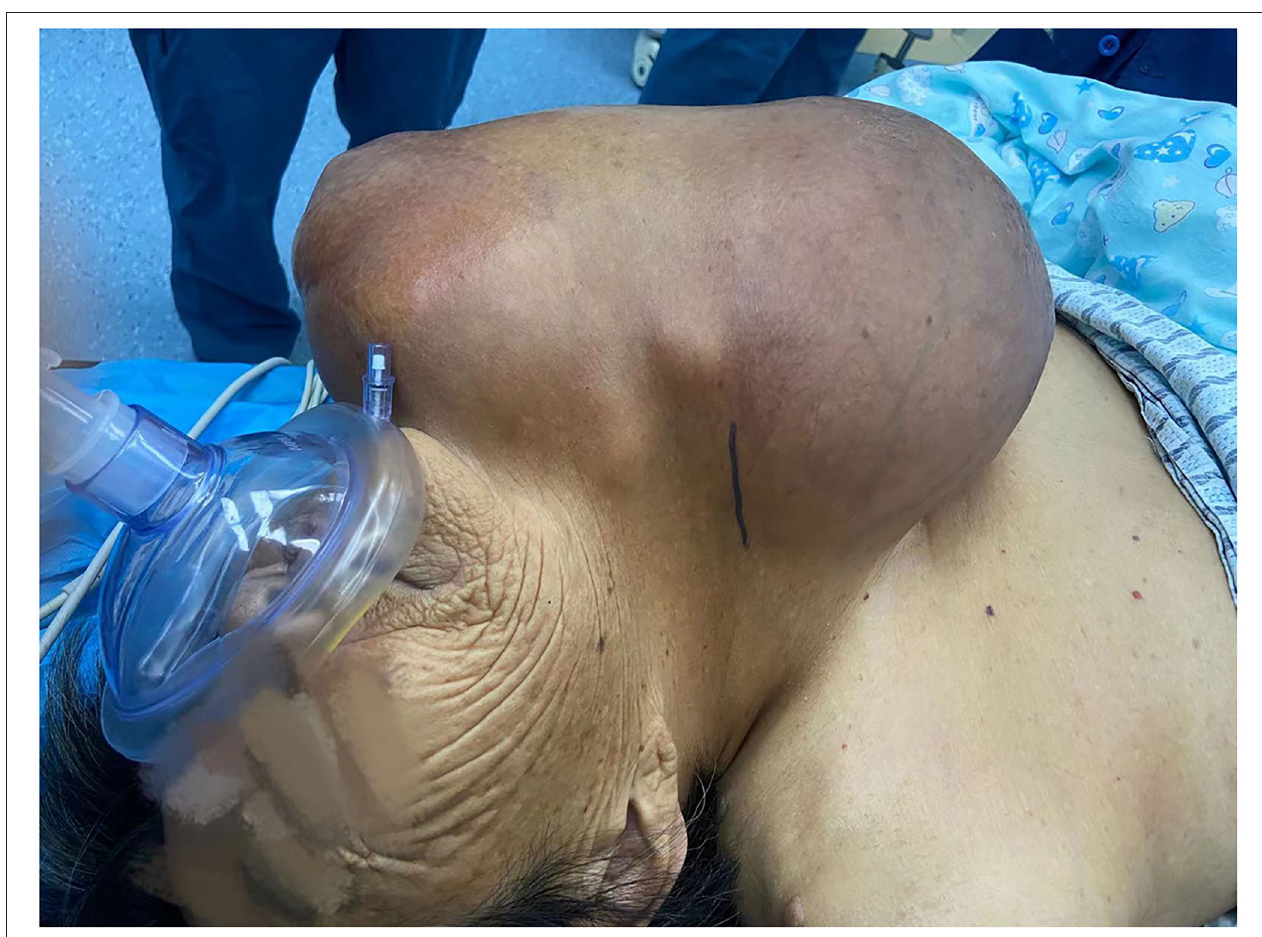
FIGURE 1 | A giant mass in the left anterior